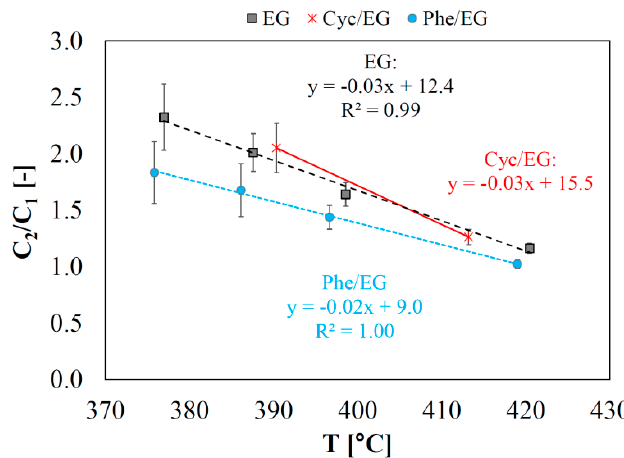
Figure 3. Selectivity towards HDO compared to cracking expressed as the C 2 / C 1 gaseous product ratio as a function of measured reaction temperature from the conversion of ethylene glycol in experiments with pure ethylene glycol and mixtures of cyclohexanol / EG and phenol / EG. Data taken from the final 5 h of each operating temperature. Error bars show two standard deviations.